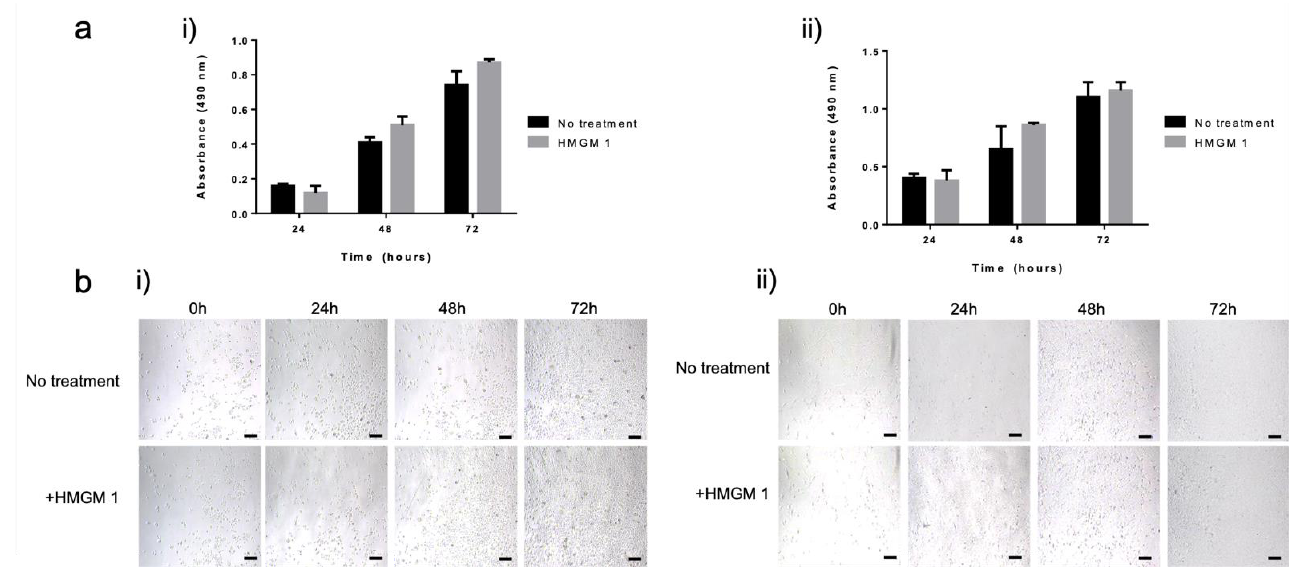
Figure 6. Proliferation of NHEK and NHDF cells over time under normal culture conditions and exposed to HMGM 1 hydrogels. ( a ) Relative proliferation of (i) NHEK and (ii) NHDF cells. Absorbance is proportional to cell number, quantified by measuring mitochondrial metabolism (MTS assay) at 24, 48, and 72 h. ( b ) Phase microscopy images showing plated (i) NHEK and (ii) NHDF at 0, 24, 48, and 72 h. Scale bar—50 µ